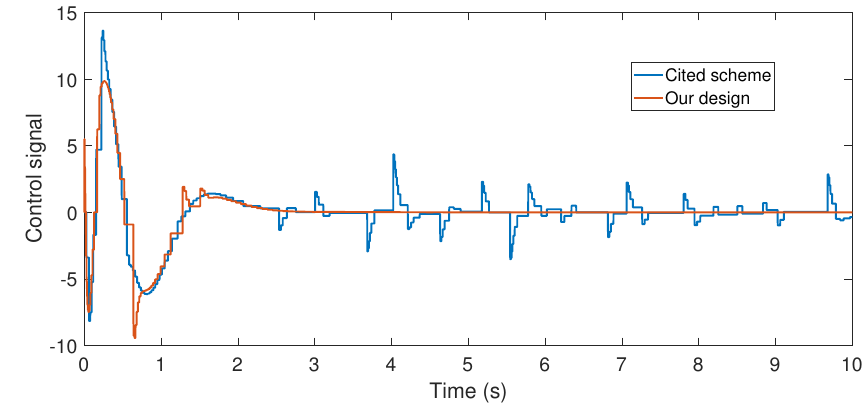
Figure 5. Numerical experiment results: control signal (N).